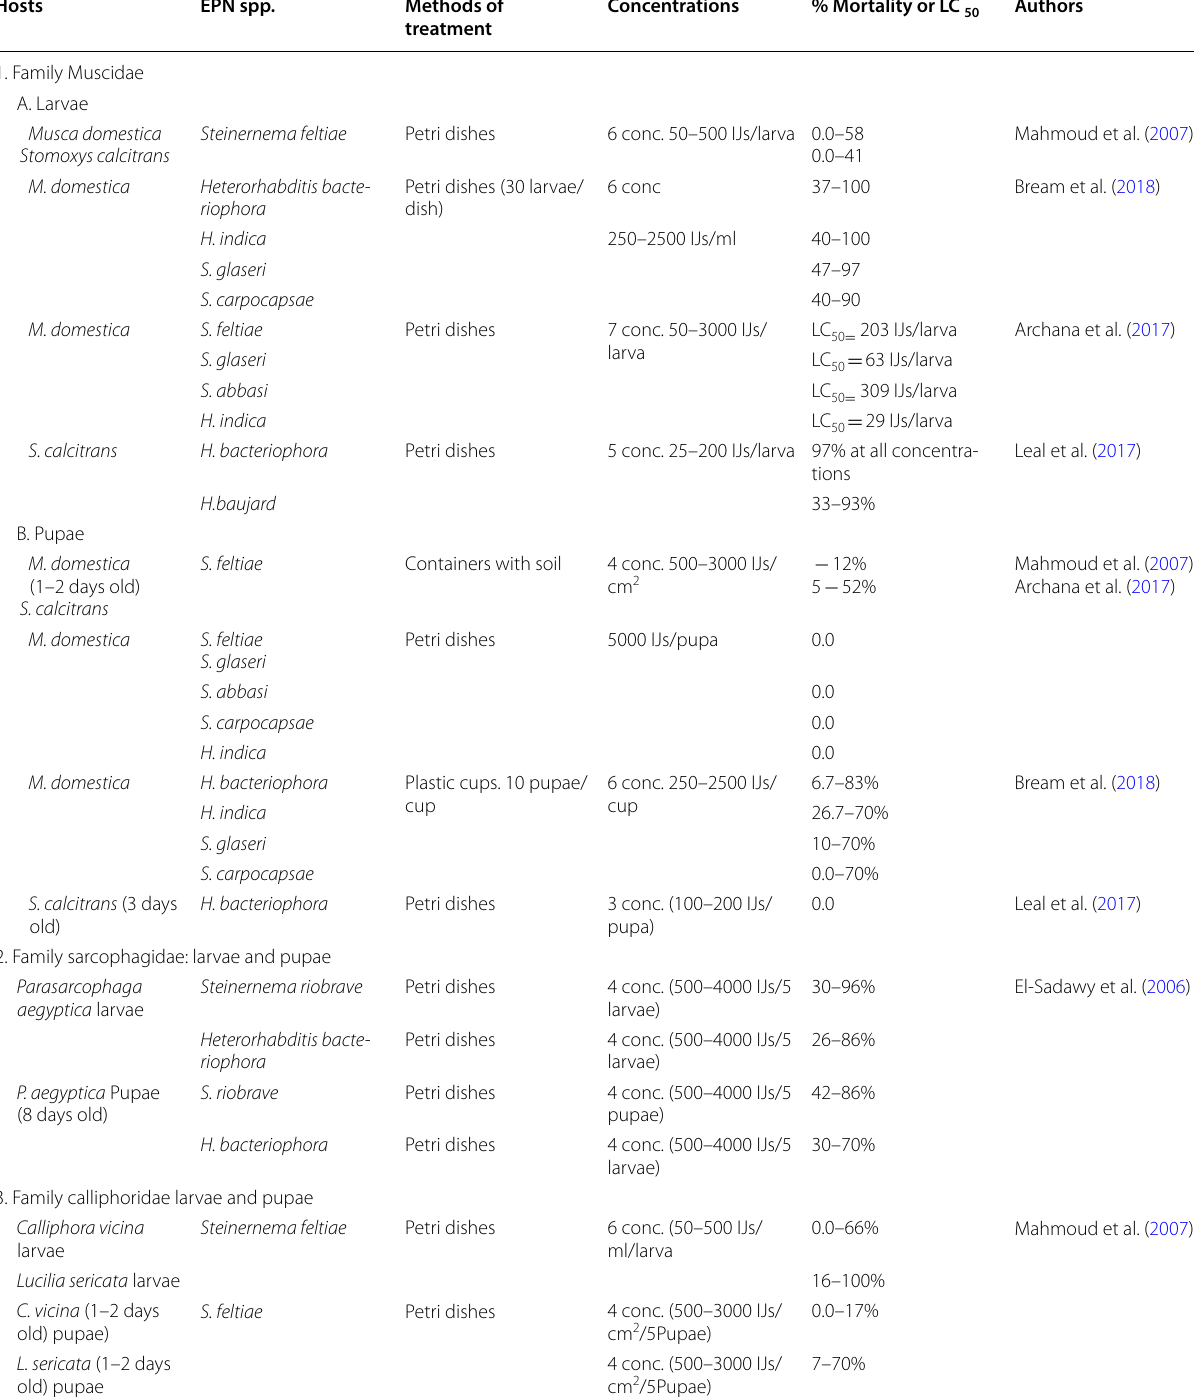
Table 2 Efficiency of entomopathogenic nematodes against houseflies Hosts EPN